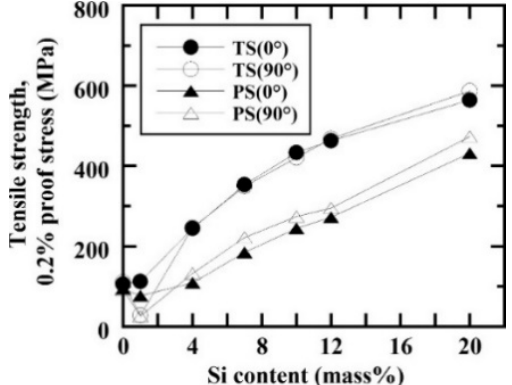
Figure 56. Tensile strength and proof stress of Al-xSi SLM samples fabricated using the optimal laser scanning parameters [136]. Copyright 2016. Adapted with permission from Elsevier Science Ltd.